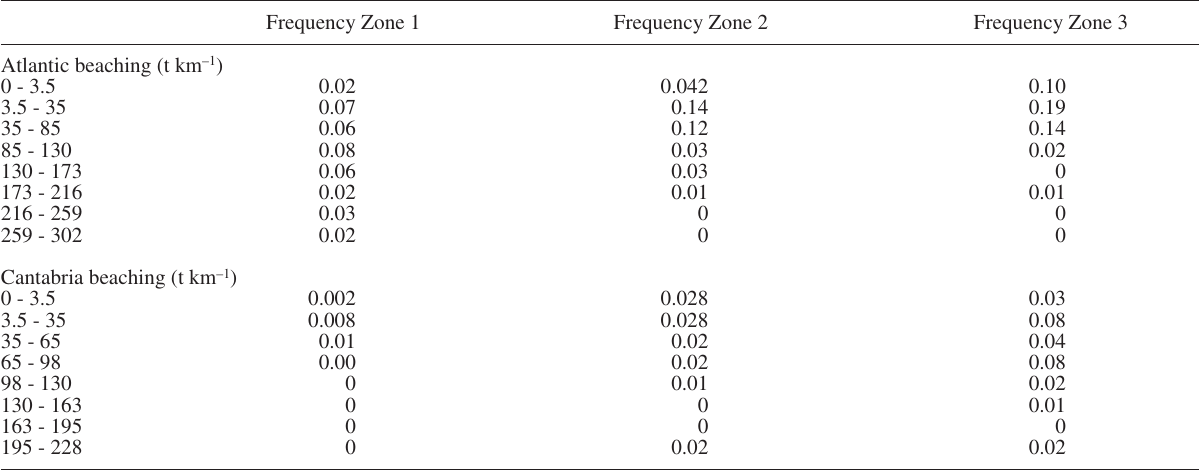
Table 4. – Frequencies of different beaching classes for the Atlantic Islands National Park coast and for the Santoña marsh Ramsar park, according to the predictions of the complex model, when the particles are released from Zones 1, 2 and 3, respectively.